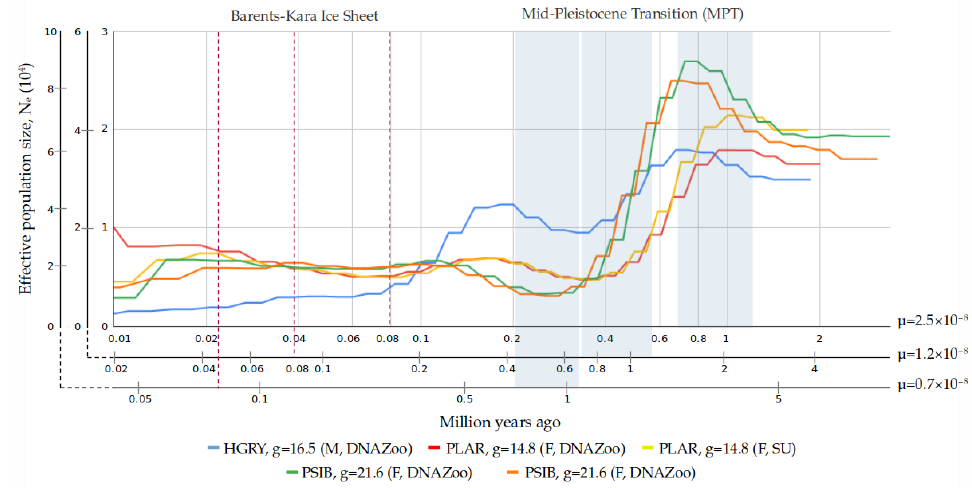
Figure 4. Demographic history reconstruction for all available samples of PSIB , HGRY, and PLAR . Three time scales were used for each value of mutation rate (μ = 2.5 × 10 −8 substitutions per site, μ = 1.2 × 10 −8 , and μ = 0.7 × 10 −8 ). Generation time (years) was set at different times between the species: PSIB — 21.6 years, HGRY — 16.5 years , PLAR — 14.8 years.